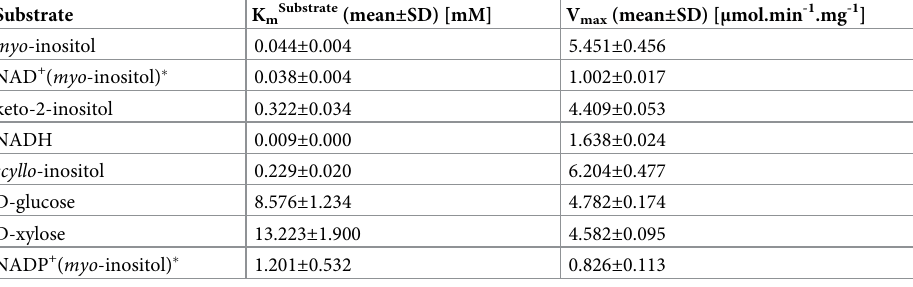
Table 1. Kinetic parameters of E . histolytica myo -IDH.